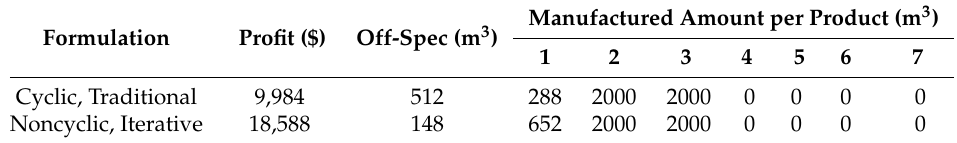
Table 10. Economic results: Scenario 1.